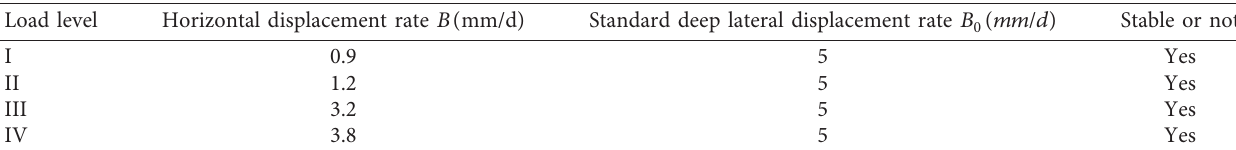
Figure 10: Deep lateral displacement of soil at different depths with time of the foot on the embankment in all stages. Table 3: Deep lateral displacement rate for the preload control period in each